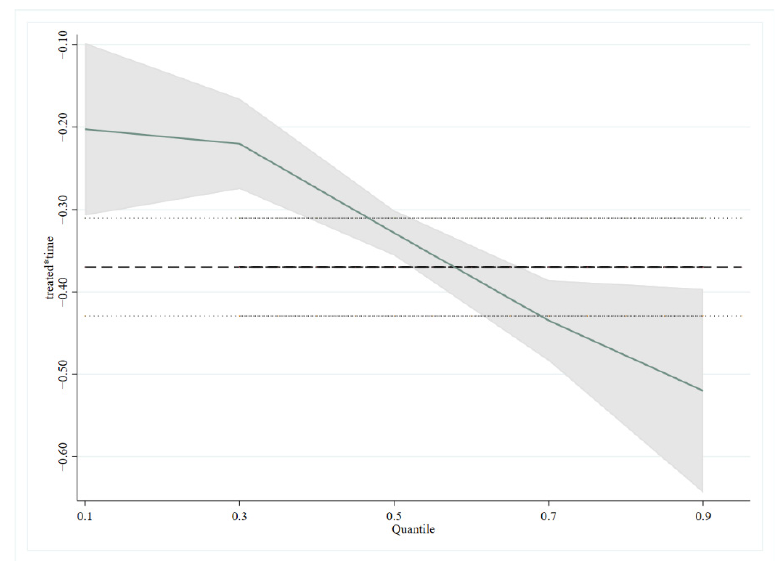
Figure 3. Quantile regression trend of carbon intensity of cities under ETS.